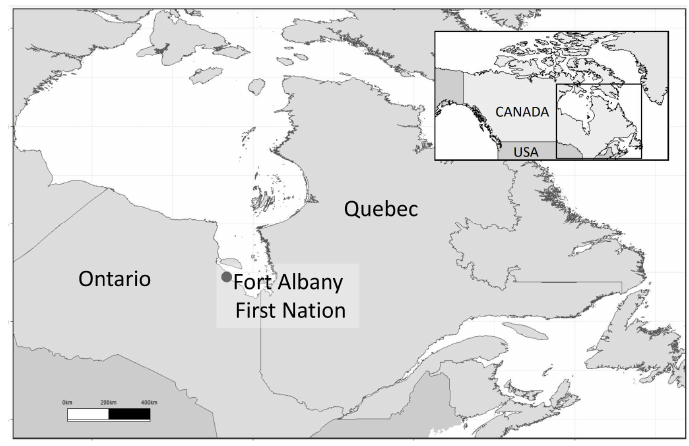
Figure 1. A map of Fort Albany FN, Ontario, CA.